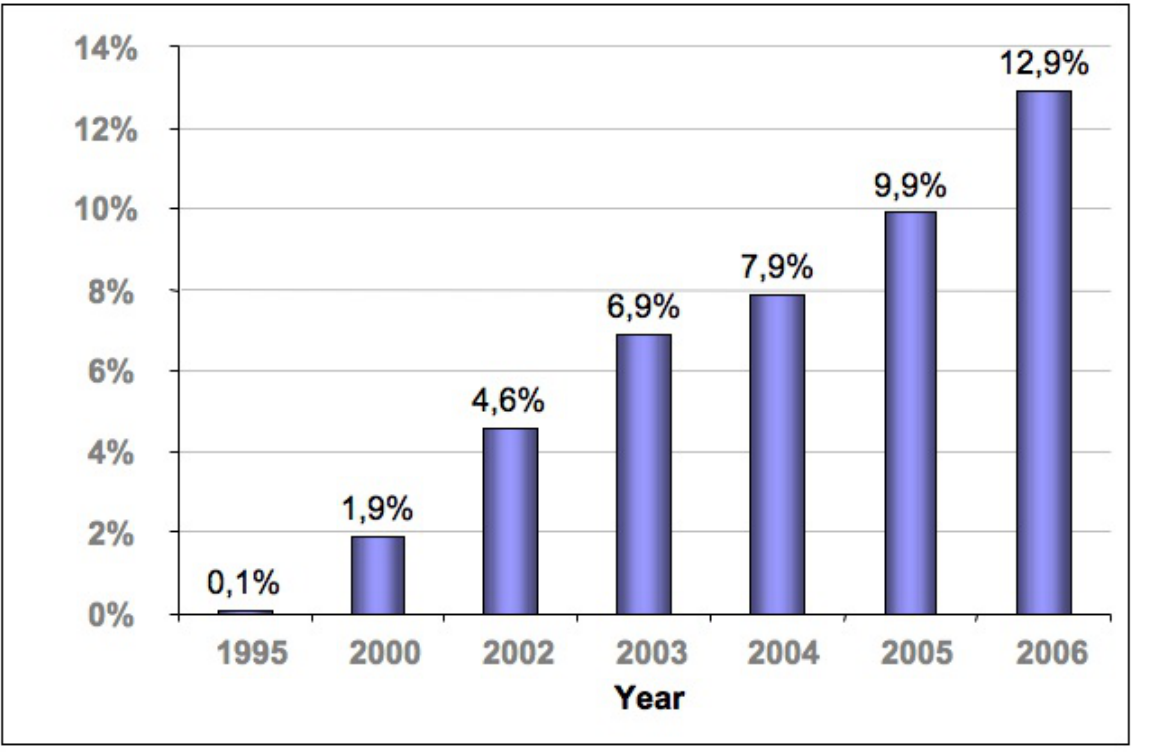
Figure 1. Internet penetration in Colombia